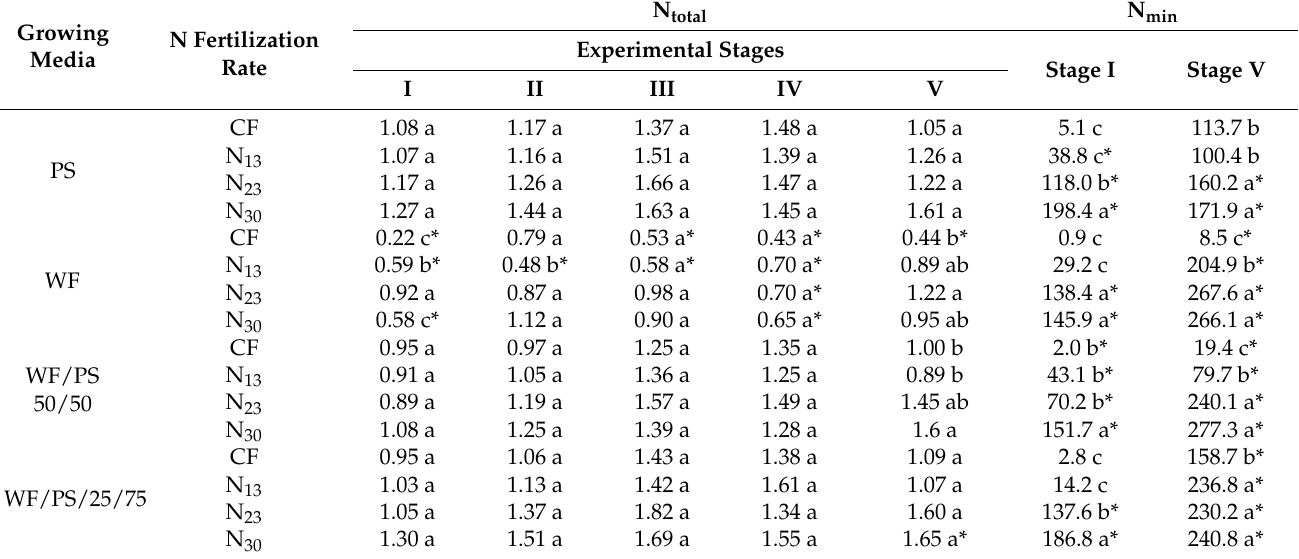
Table 2. The influence of conventional fertilization (CF) and additional nitrogen fertilization with N 13 , N 23 , or N 30 on total (N total %) and mineral (N min mg kg − 1 ) nitrogen content in four cucumber- growing media: 100% peat substrate (PS), 100% wood fiber (WF), 50/50 wood fiber/peat volume ratio (WF/PS 50/50), and 25/75 wood fiber/peat volume ratio (WF/PS 25/75). I–V—five